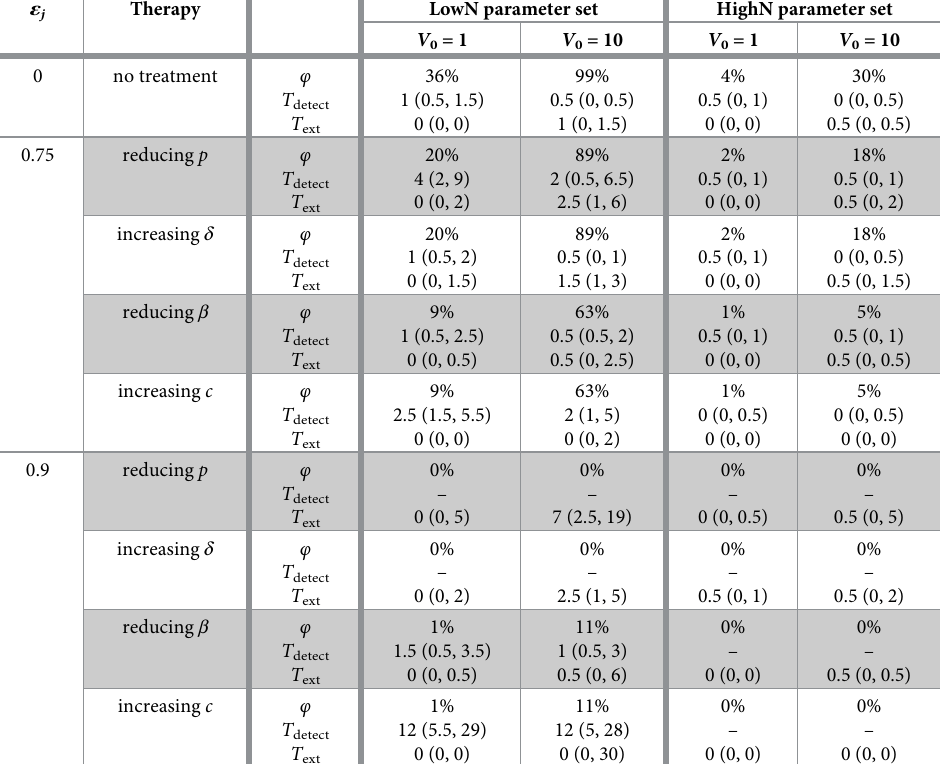
Table 3. Establishment probabilities ( φ ), times to detection ( T detect ) and extinction time ( T ext ) statistics for various sets of antiviral treatment. ε j Therapy